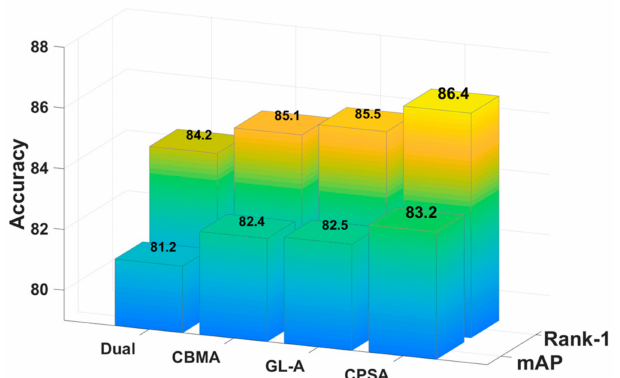
Figure 12. The comparative experiments of CPS-Attention on CUHK-03(detected).